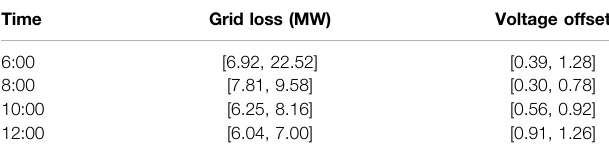
TABLE 4 | Comparison of optimal power fl ow results. Time